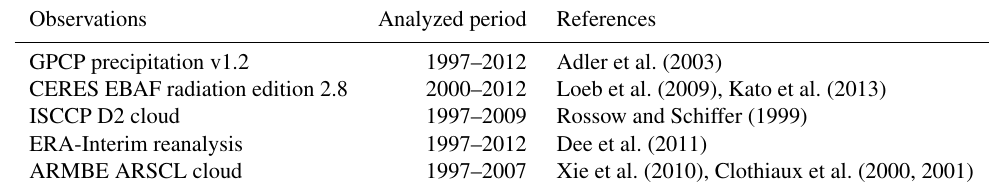
Table 2. List of observation